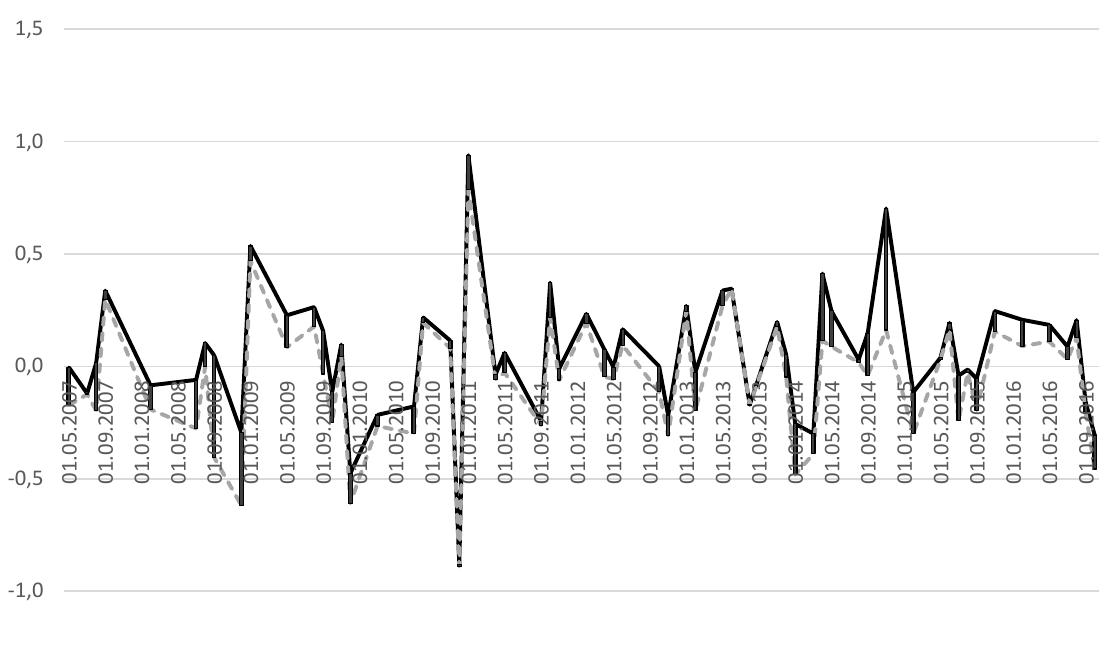
Figure 3. The difference between gap of demand and supply function at the